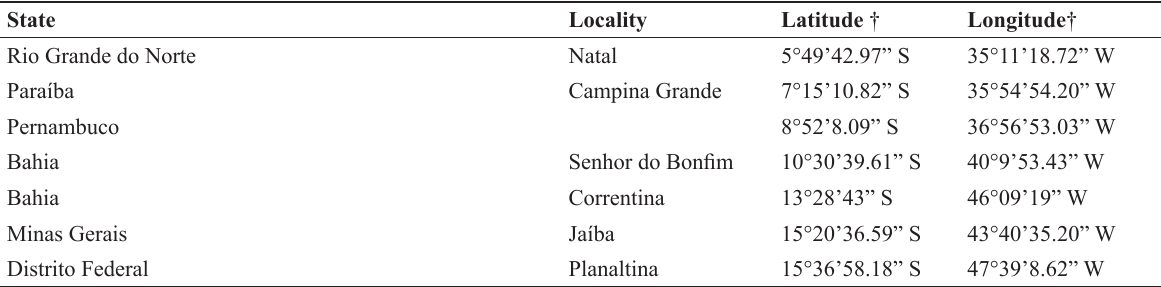
Geographical coordinates of known distribution o f Utetheisa pulchella (Linnaeus, 1758) in